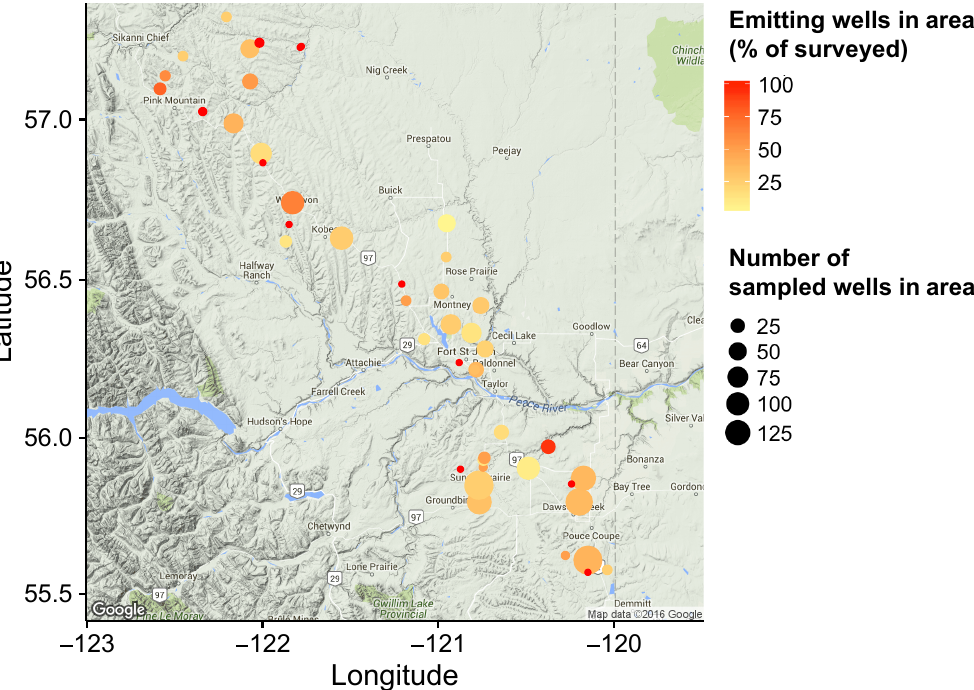
Figure 11. Distribution of emitting infrastructure by industry-defined area. The size of the circles represents the number of measurements we took downwind from individual wells or facilities in each area. The colour of the circles represents the frequency of emitting infrastructure in each